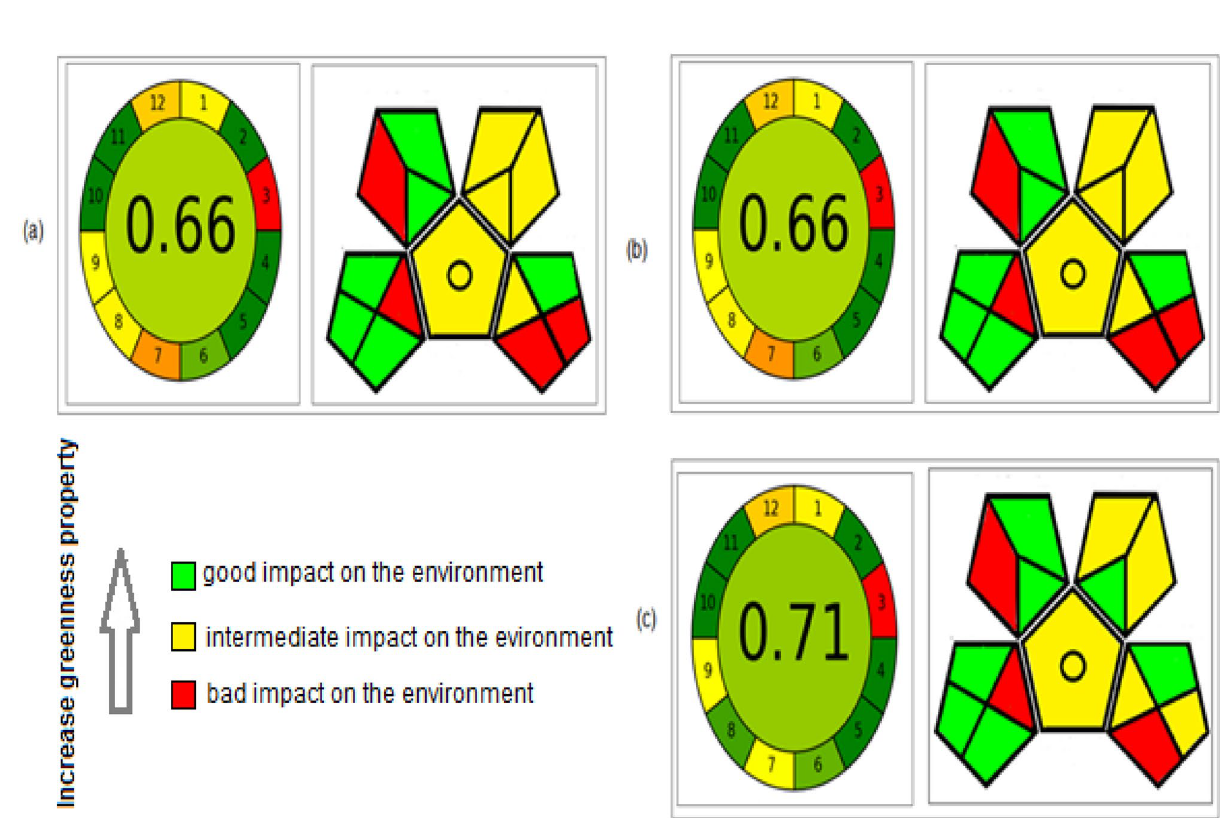
Figure 4. Greenness evaluation by AGREE and GABI, where ( a ) Evaluation for the reported HPLC method 3 . ( b ) Evaluation for the reported HPLC method 22 . ( c ) Evaluation for the suggested HILIC